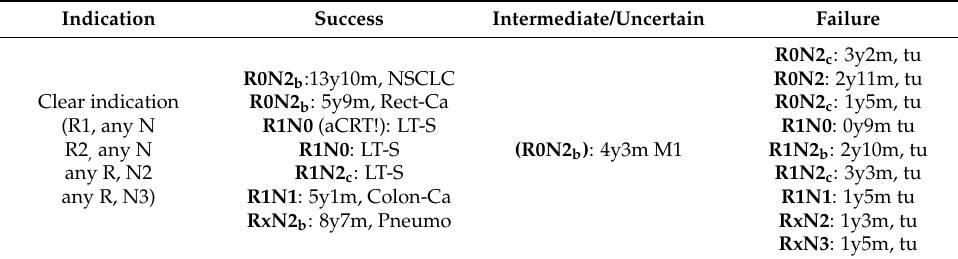
Table 6. Success and failure, respectively, after aRT in T2 supraglottic cancer patients with a clear indication for adjuvant treatment. Each patient defined by his resection (R) and lymph node (N) status in bold letters, followed by OS [y=years, m=months], and cause of death; LT-S = long-term survivor, i.e., living at the end of follow-up time; tu = death due to locoregional recurrent tumor; NSCLC = Non-small cell lung cancer; Rect-Ca = Carcinoma of the rectum; Colon-Ca = Colon cancer; Pneumo = Pneumonia.